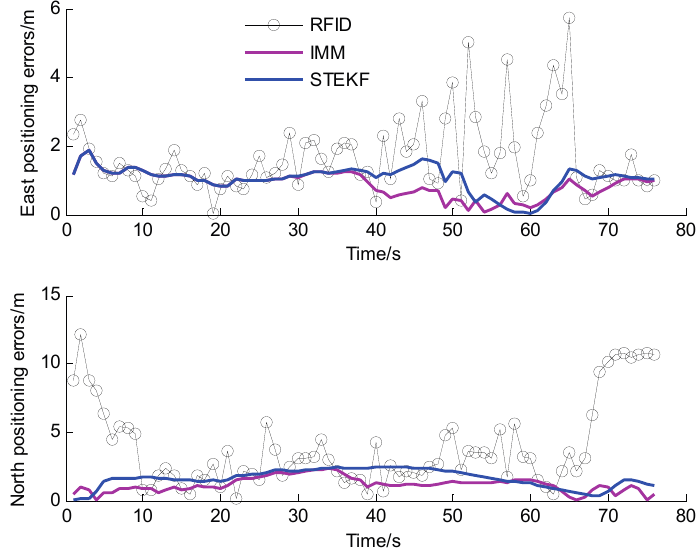
Figure 13. The east and north positioning errors in the comprehensive